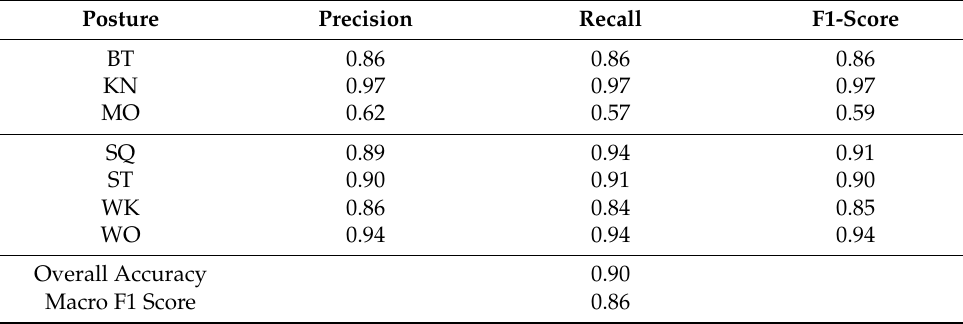
Table 9. Summary of recognition